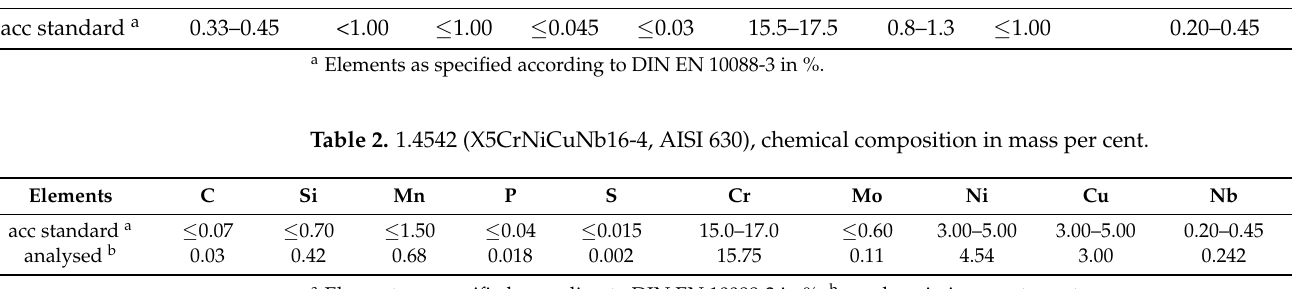
Table 1. 1.4122 (X35CrMo17): chemical composition in mass per cent.